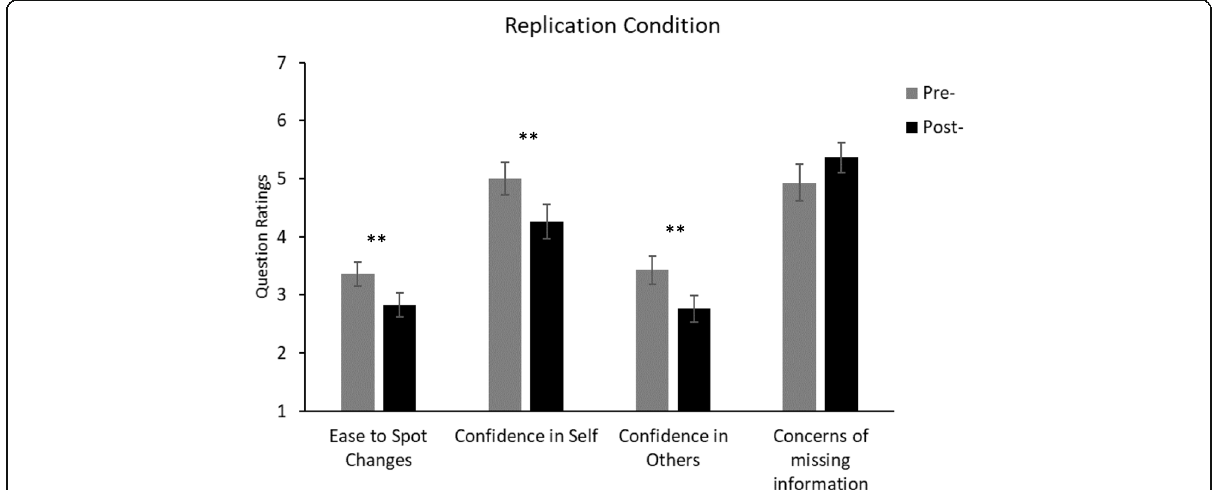
Fig. 3 Average ratings from the pre-demonstration and post-demonstration questionnaires of the replication condition in Experiment 2. For the “ ease to spot changes ” question, the rating scale ranged from 1 (very difficult) to 5 (very easy). For the other questions, the rating scales ranged from 1 (not at all confident/concerned) to 7 (totally confident/concerned). Significant difference: ** p < 0.01. Error bars represent the standard error. See Additional file 1 for the full